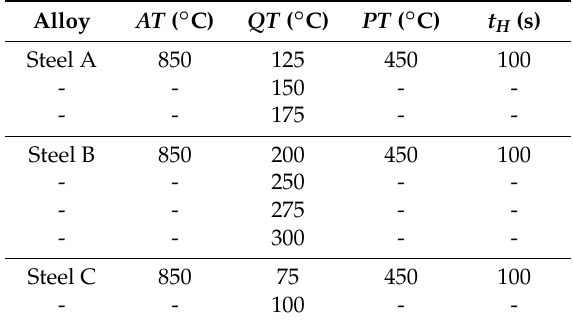
Figure 3. Schematic of the heat treatment cycle for the quenched and partitioned specimens. Table 3. Annealing temperature ( AT ), initial quench temperature ( QT ), partitioning temperature ( PT ) and holding time at partitioning temperature ( t H ) for the heat treated specimens.